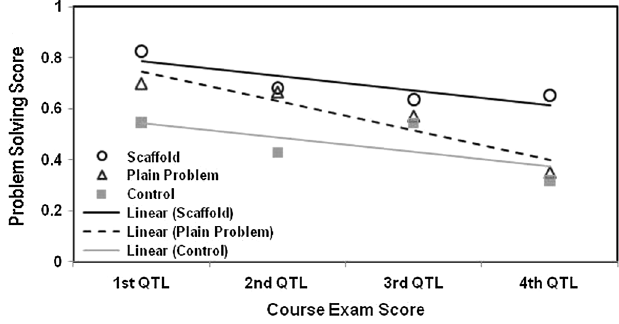
FIG. 9. Problem-solving performance for students at different course grade